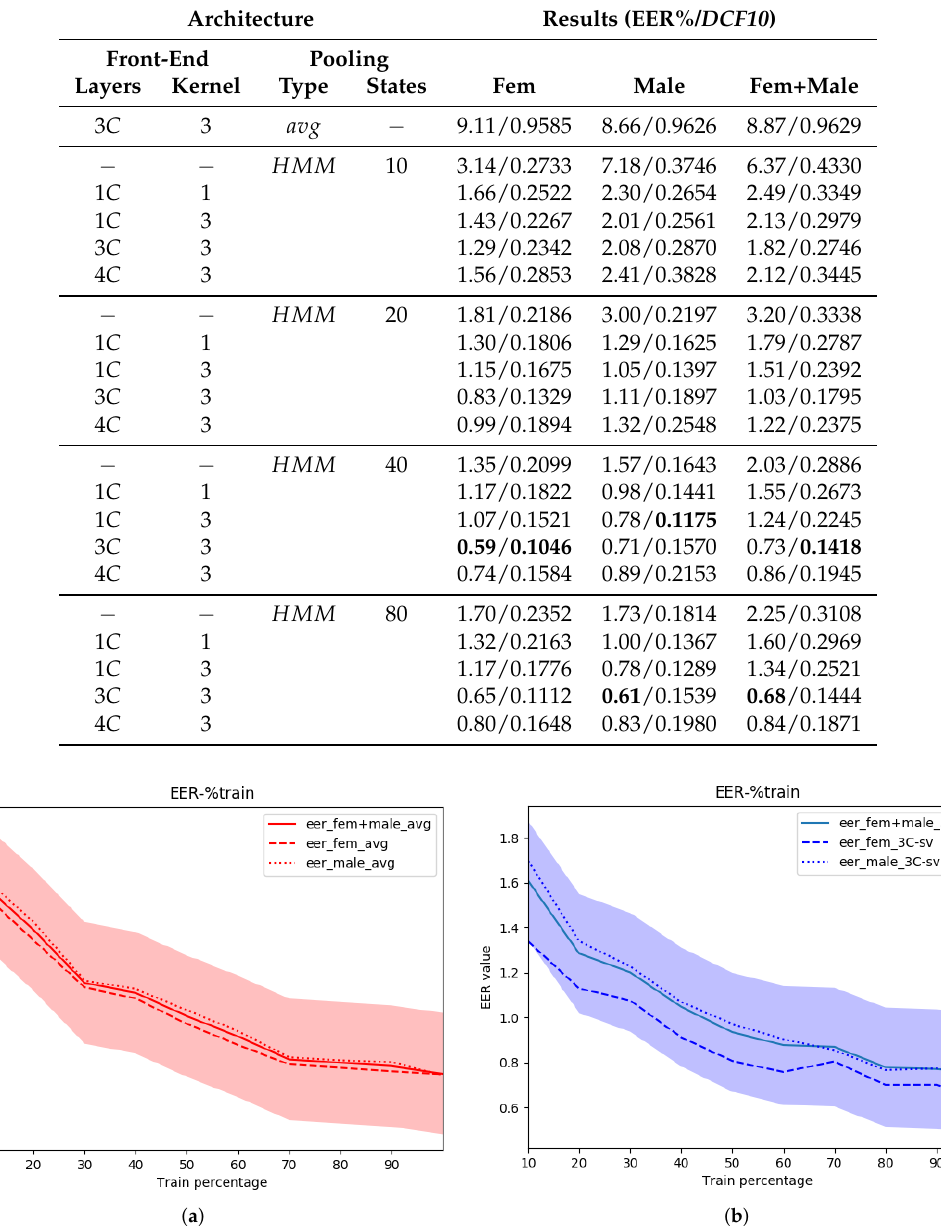
Table 2. Experimental results on RSR2015-Part I [22] eval set, showing EER% and NIST 2010 min cost ( DCF10 ). These results were obtained by training with bkg+dev subsets and by varying the number of states of the HMM. The best results are marked in bold.